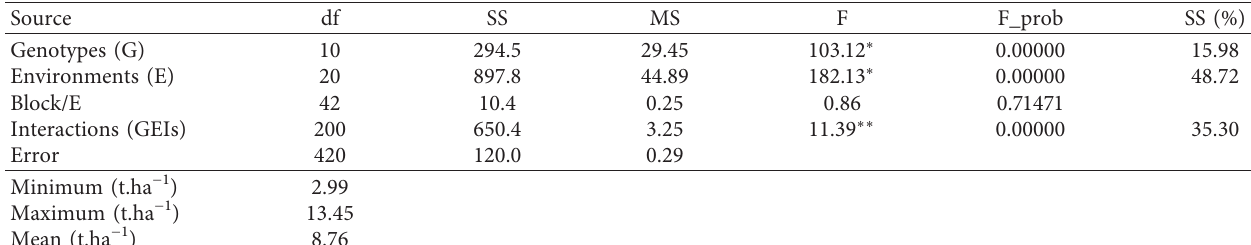
Table 3: Combined ANOVA and statistics parameters for yield of maize hybrids under different environment in the western region of Indonesia.